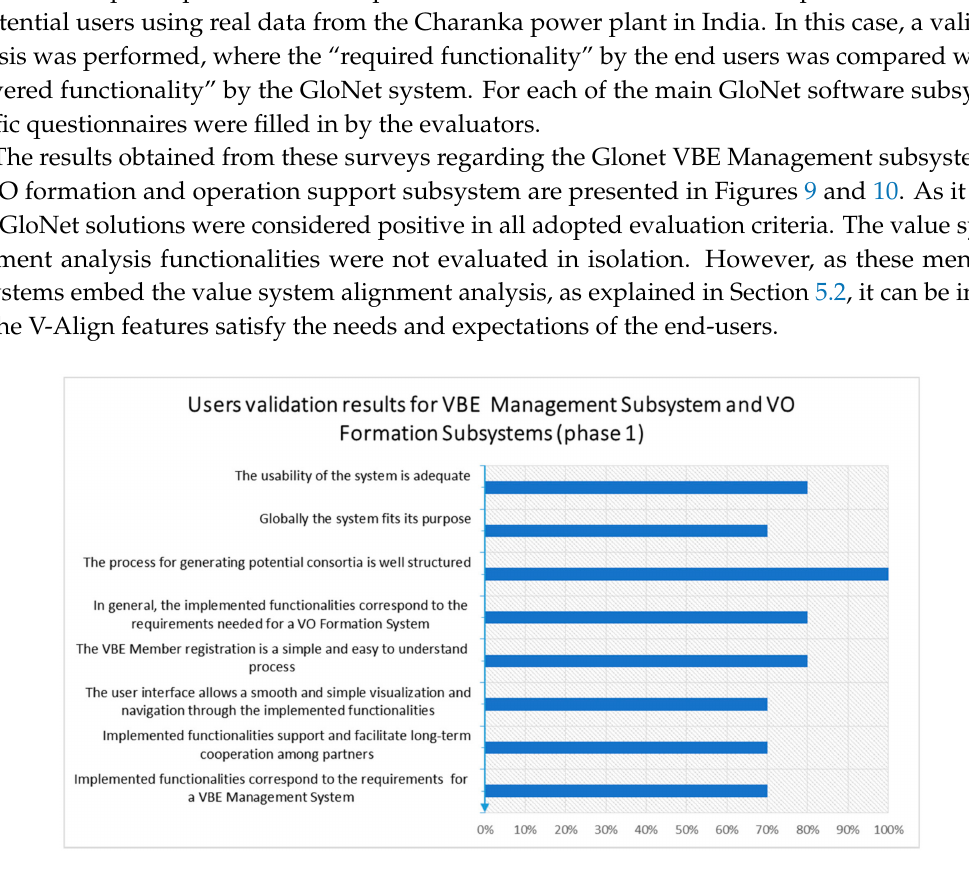
Figure 9. Assessment of subsystems by the solar energy network.